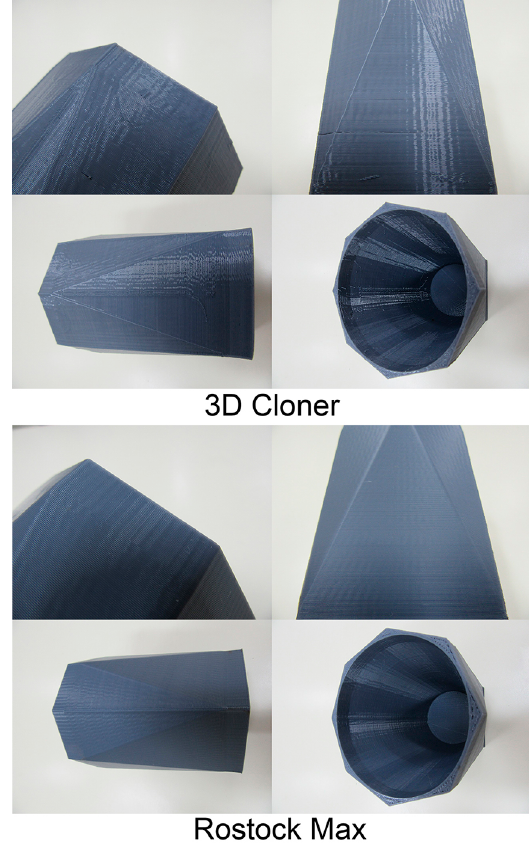
Figure 5. Surface details on 3D printed